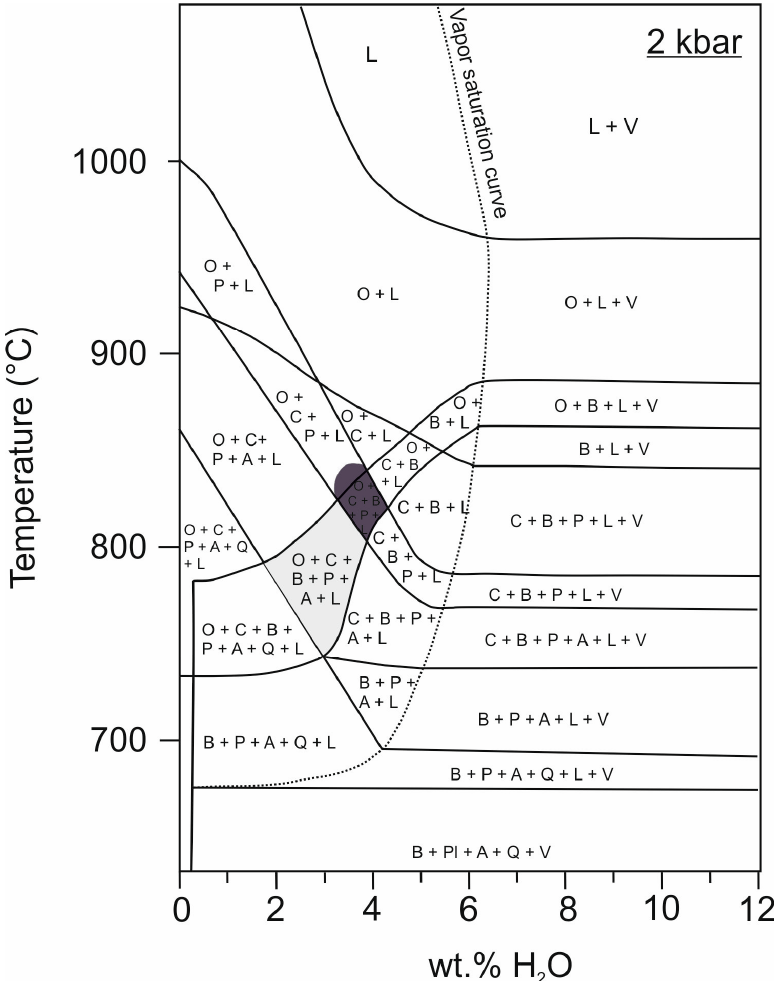
Figure 9. Mineral assemblages in the NM-57 drill core (light grey) and WM-002 drill cores (dark grey) projected on the temperature versus wt. percent H 2 O phase assemblage diagram for synthetic granite compositions [25]. (L = liquid, V = vapor, O = orthopyroxene, C = clinopyroxene, B = biotite, P = plagioclase, Q = quartz, A = alkali feldspar).